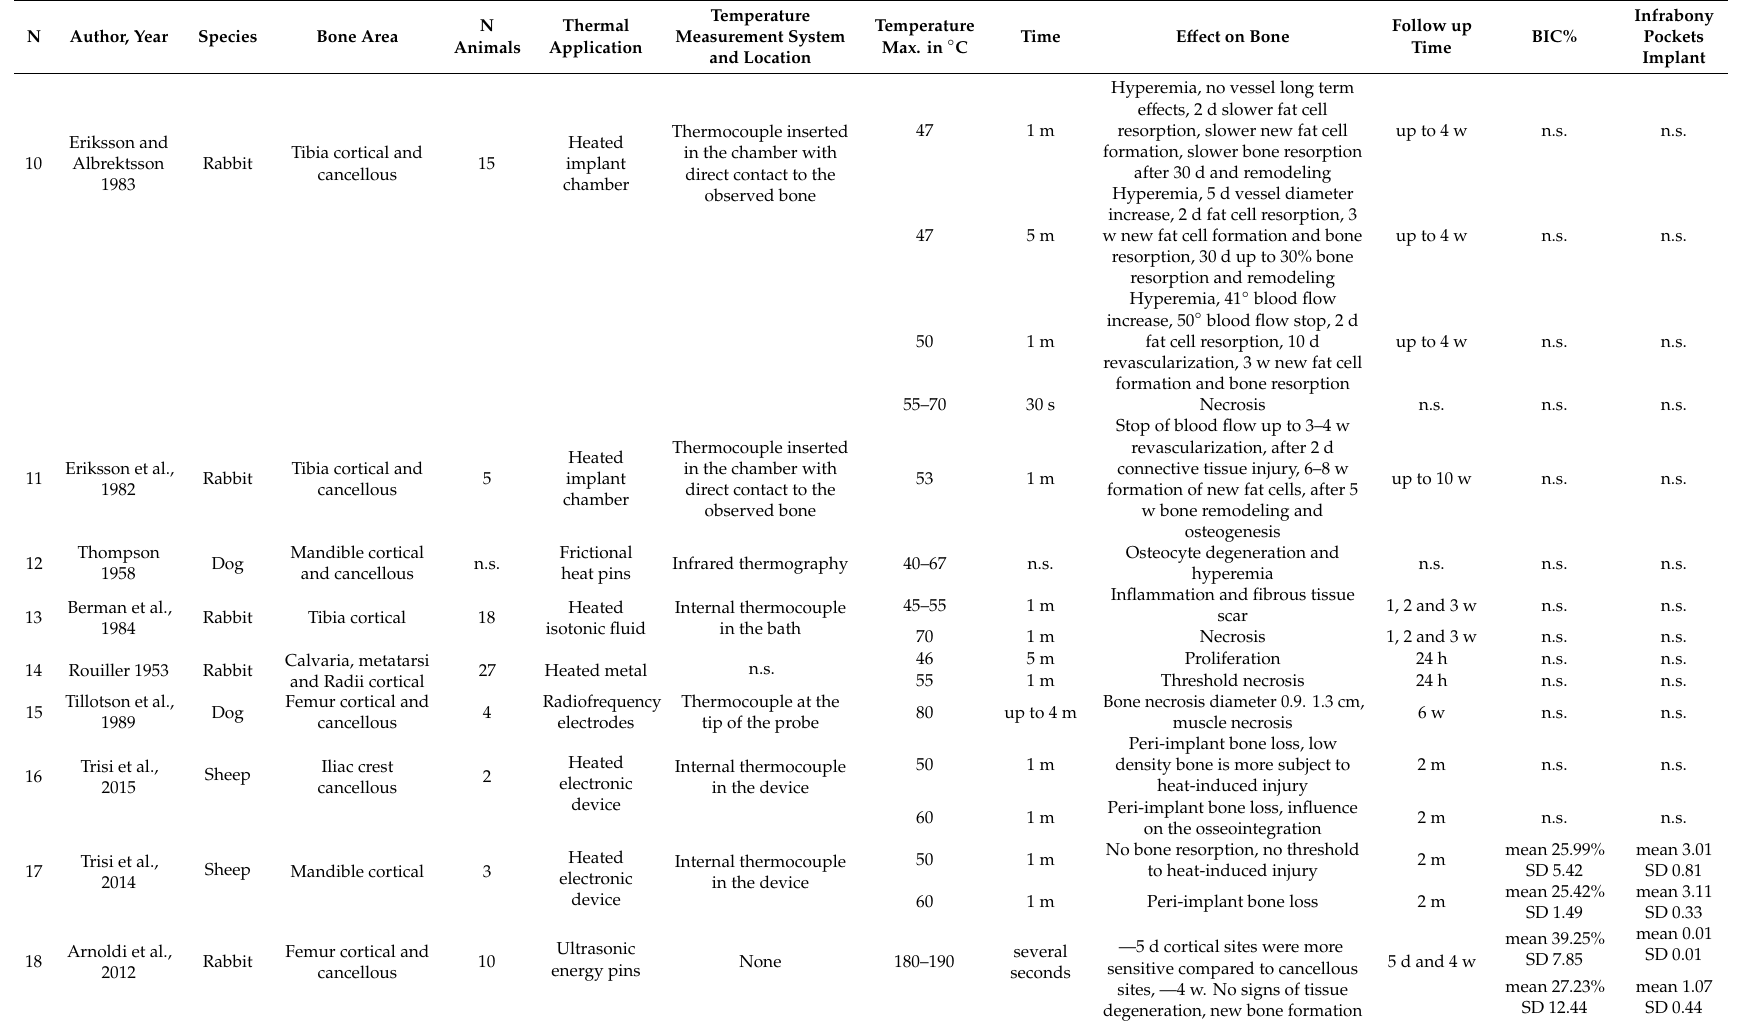
Table 3. Included animal studies evaluating temperature parameters of 47 ◦ C to 190 ◦ C on bone damage (BIC = bone-to-implant contact ratio, n.s. = not specified, s = seconds, m = minutes, h = hours, d = days, w = weeks, and mon =